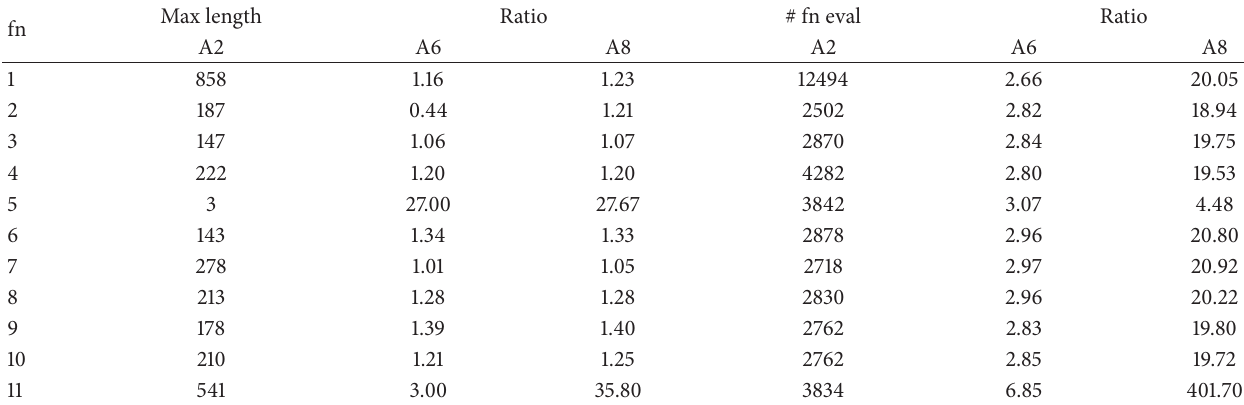
Table 8: The maximum list length from A2 and the ratio of the maximum list length from A6 and A8 to the maximum list length from A2 when 𝑛 = 40 . Also the result of the total number of function evaluations ( 𝐹 and 𝑓